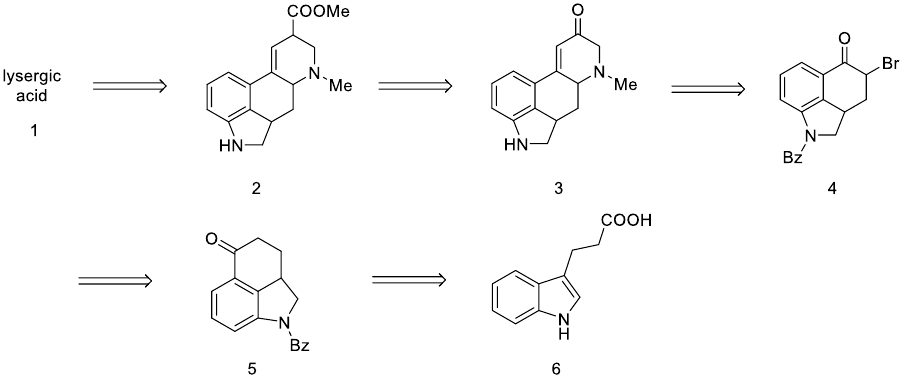
Scheme 1. Retrosynthetic analysis leading to substrate in the Woodward